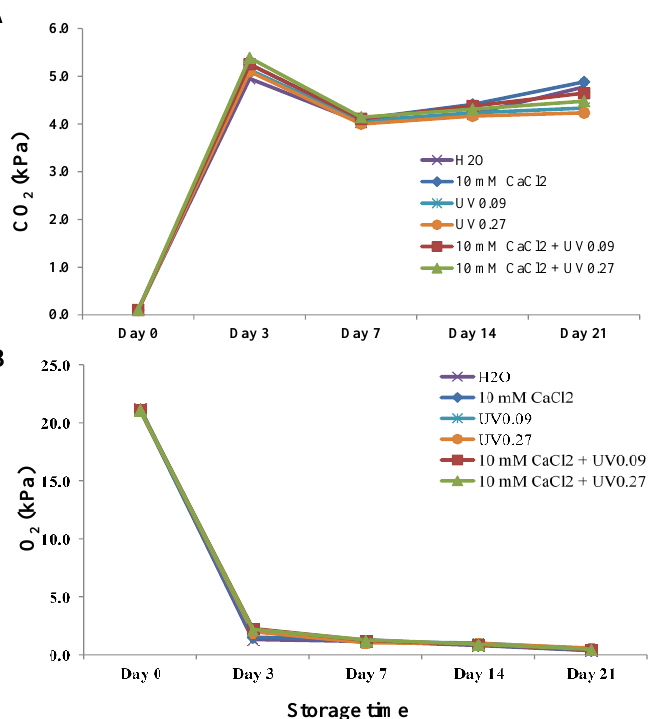
Figure 1. Effects of preharvest treatments on CO 2 − ( A ) and O 2 − ( B ) partial pressure within package on broccoli microgreens during cold storage (4 °C). UV0.09: 0.09 Wh/m 2 UVB; UV0.27: 0.27Wh/m 2 UVB. Data presented are the means of three replicates.